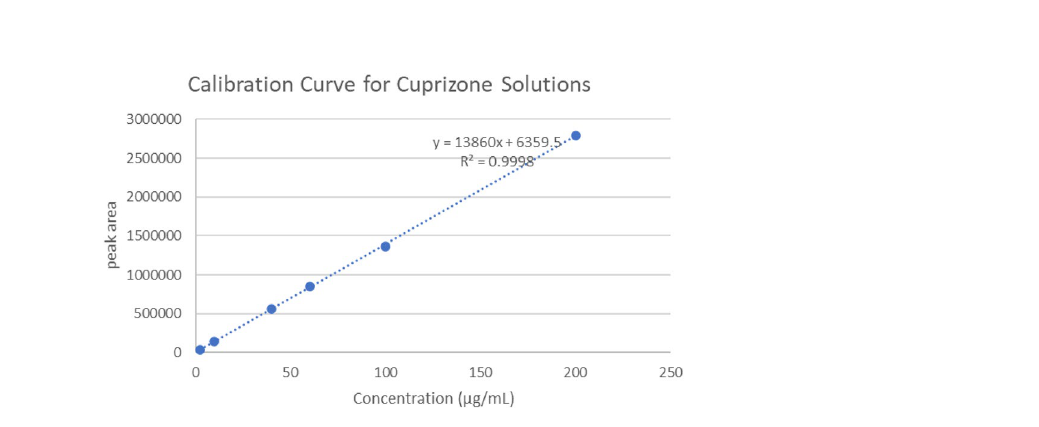
Table 5. Results of solvent standards for validation.